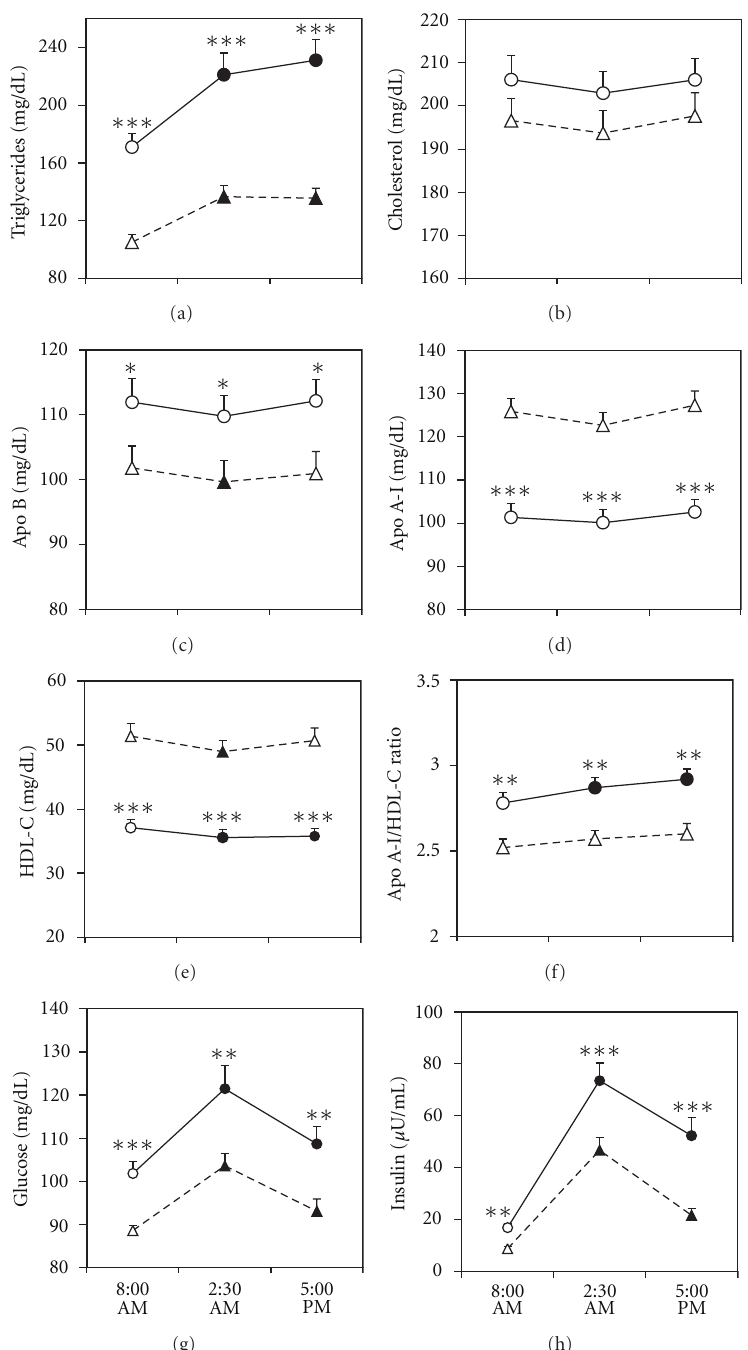
Figure 1: Line plots show the postprandial responses of serum lipids, HDL cholesterol, apolipoprotein A-I and B, blood glucose, and insulin in patients with MetS ( – (cid:2) – ) and without MetS (-- (cid:2) --). Vertical bars are the standard error of the mean. Filled symbols represent significant di ff erence from baseline. ∗ P < 0 . 05, ∗∗ P < 0 . 01, ∗∗∗ P < 0 . 001 versus patients without